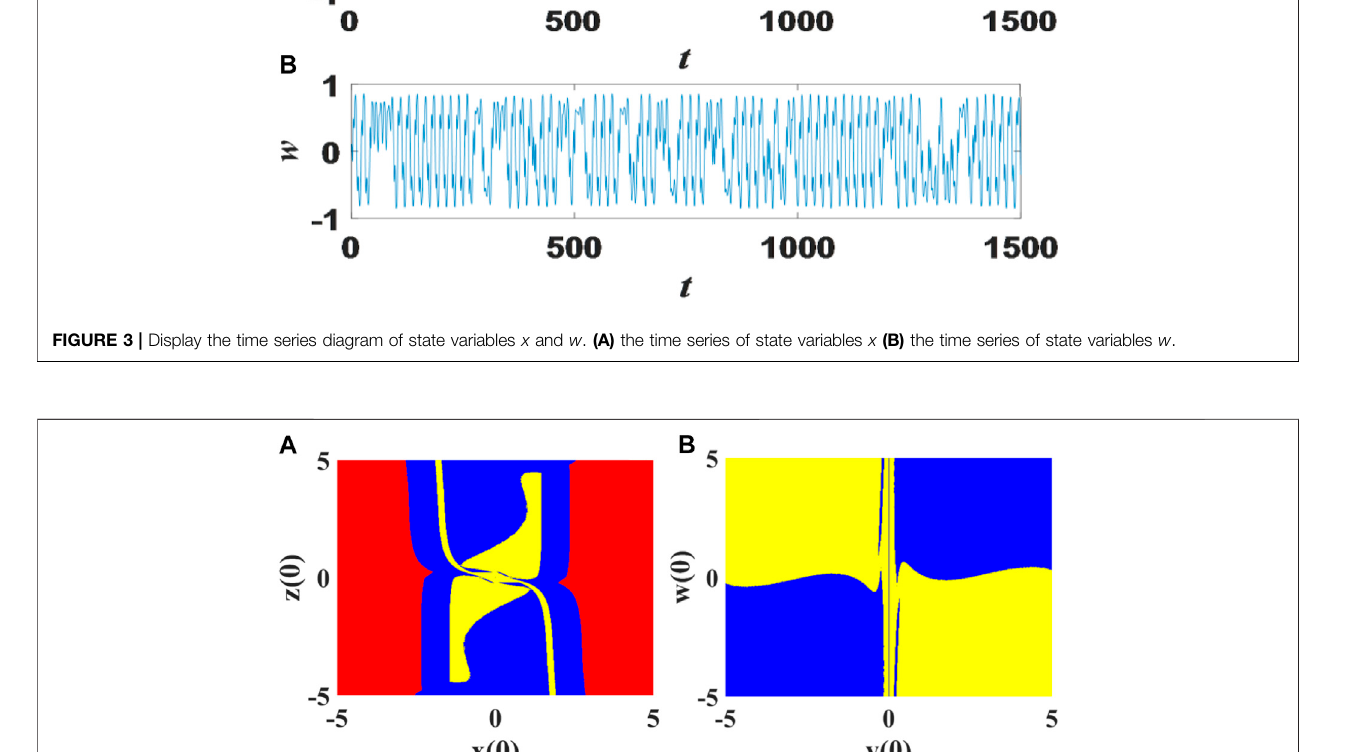
Figure 8 . In the entropy source unit, the lyapunov exponent of the fi rst dimension of Eq. 1 is the largest, indicating that the sensitivity of neuron x is higher, and the change of neuron x will cause the change of other neurons and the magnetic fl ux passing through neurons.